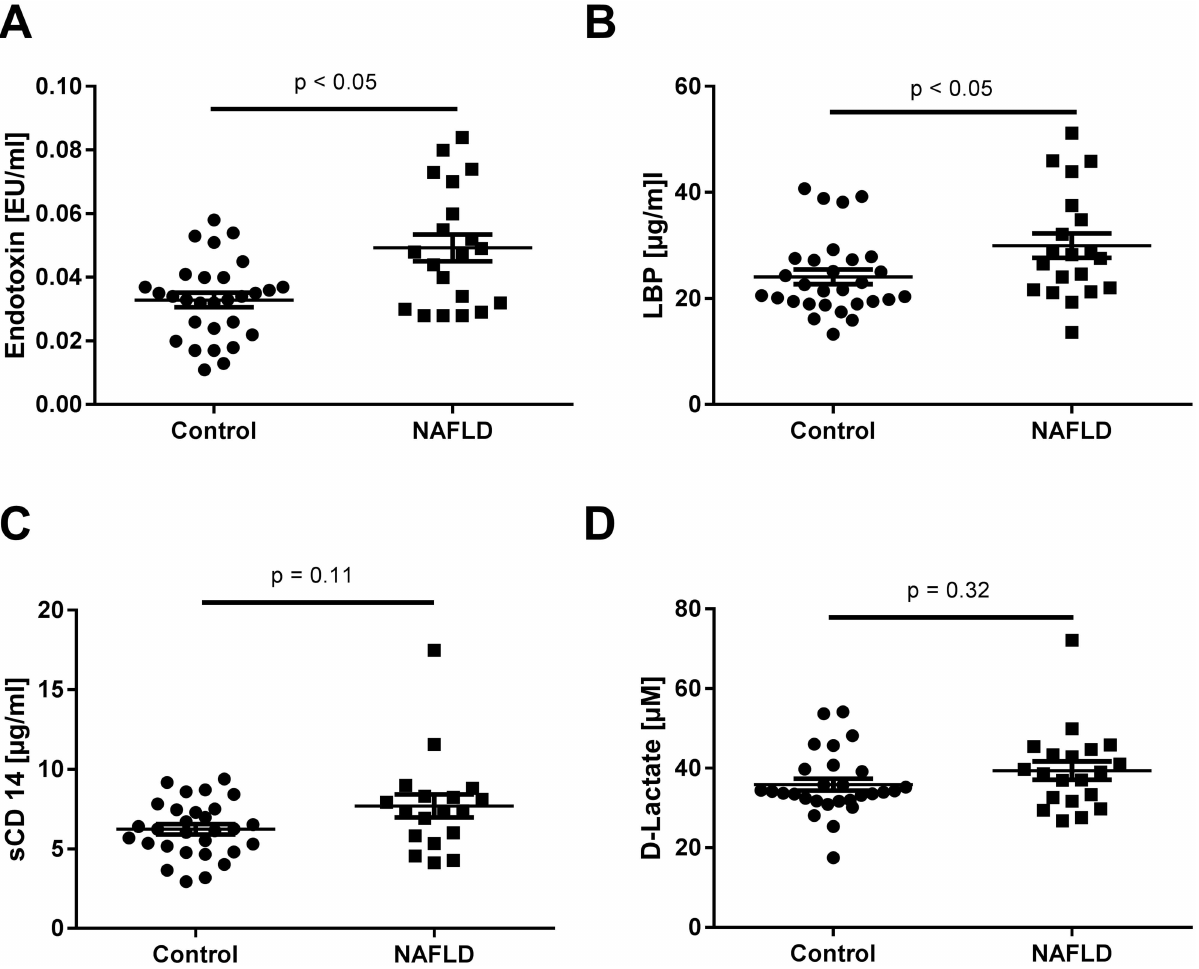
Fig 1. (A) Endotoxin and (B) LBP plasma concentrations as well as (C) sCD14 serum concentrations and (D) D-lactate plasma levels in controls and children with early signs of NAFLD. Data are shown as mean ± SEM, p < 0.05 is considered as significant comparedto healthy control children.LBP: lipopolysaccharide-binding protein, sCD14: solubleCD14, NAFLD: non-alcoholic fatty liver disease.